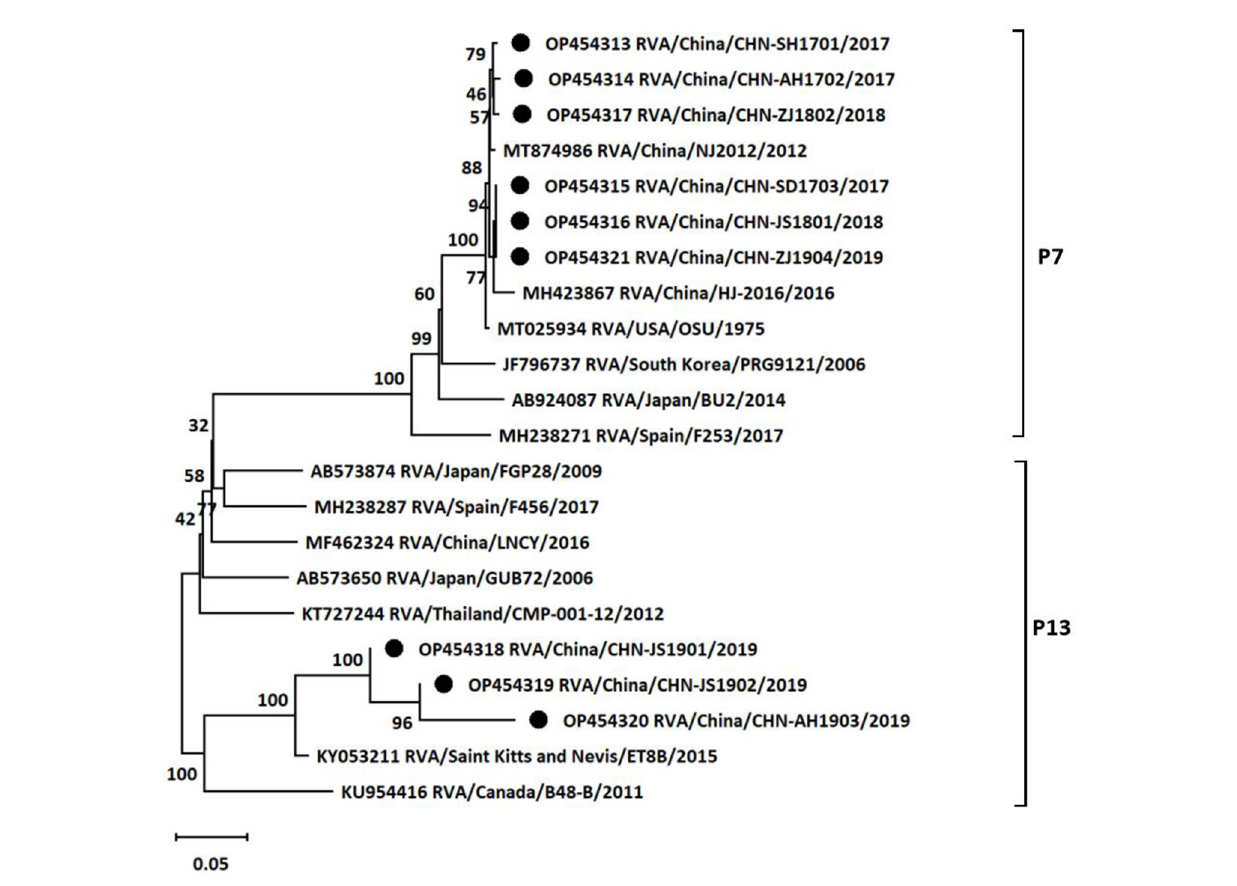
FIGURE3 Phylogenetic tree based on the nucleotide sequences of VP4 genes from different porcine rotavirus strains: phylogenetic tree was constructed by neighbor-joining (NJ) method for the VP4 sequences of different strains using MEGA11 software. Bootstrap values were calculated on 1,000 replicates. The evolutionary distances were computed using the p -distance method. Other parameters were preserved by default. The nine strains from the positive samples were labeled with black circles.